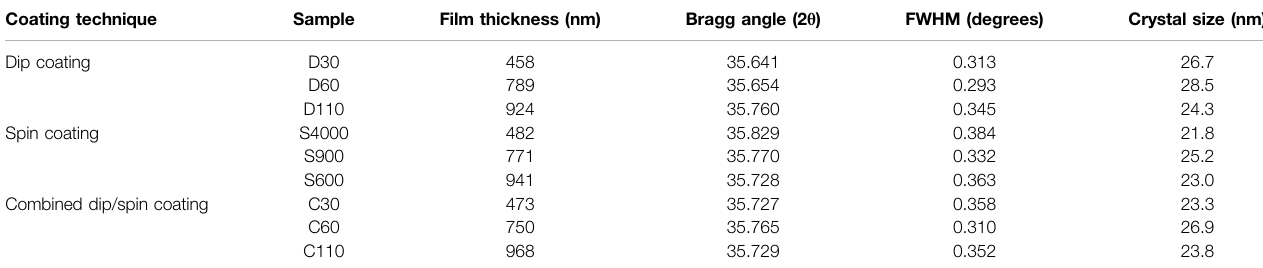
TABLE 1 | The FWHM and crystal sizes estimated for the α -Fe 2 O 3 fi lms of various thicknesses prepared using different coating techniques. Coating technique